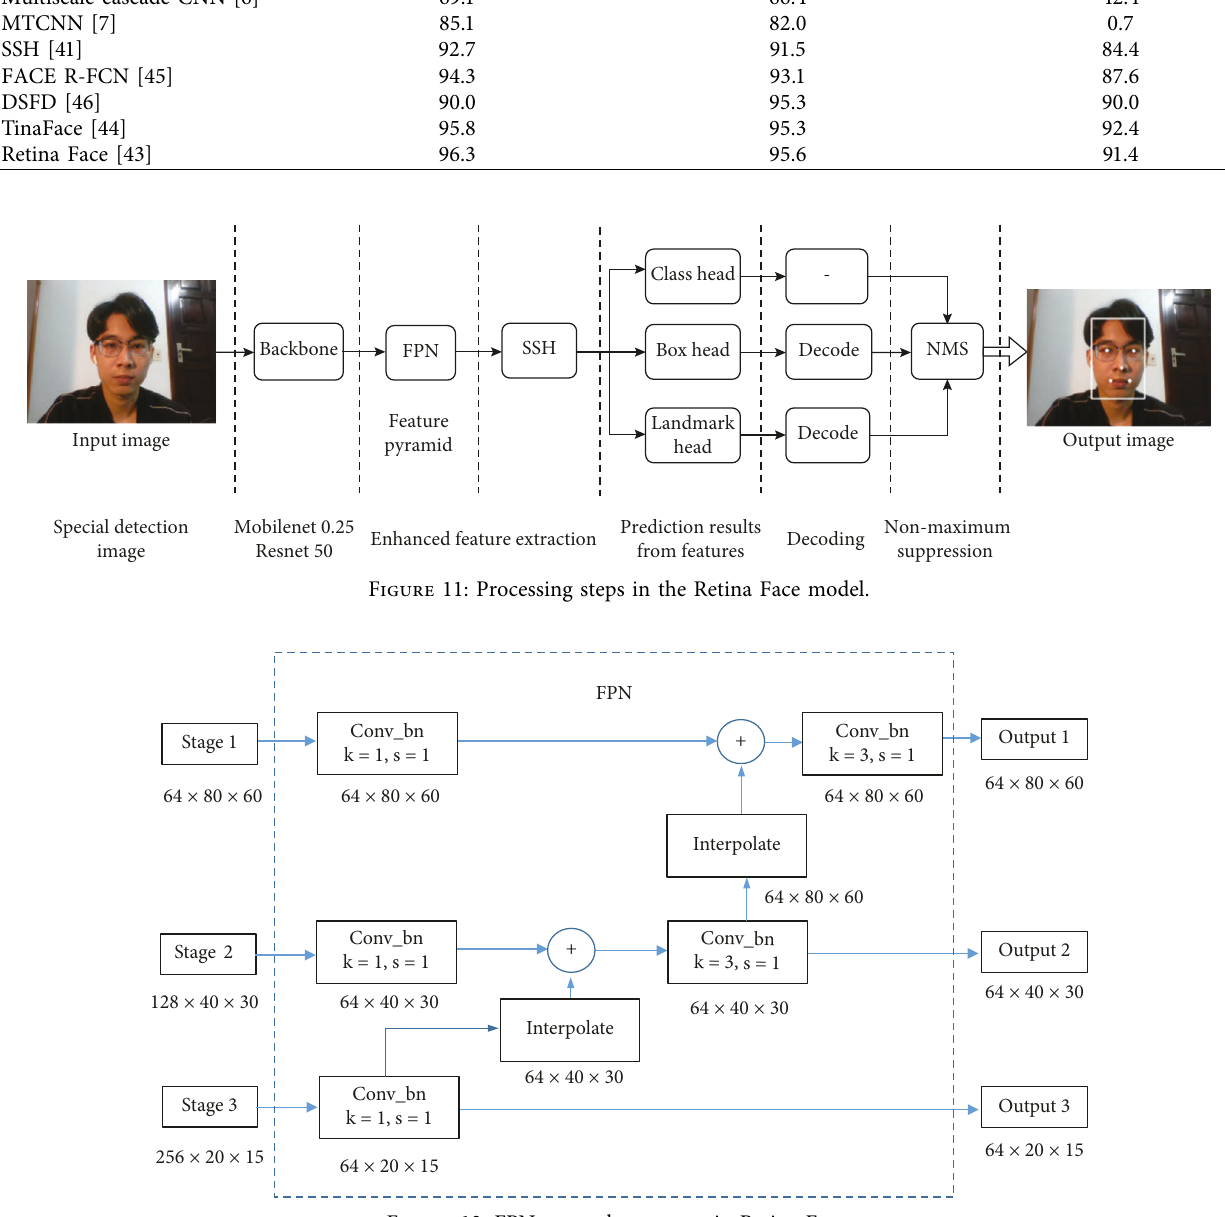
Figure 12: FPN network structure in Retina